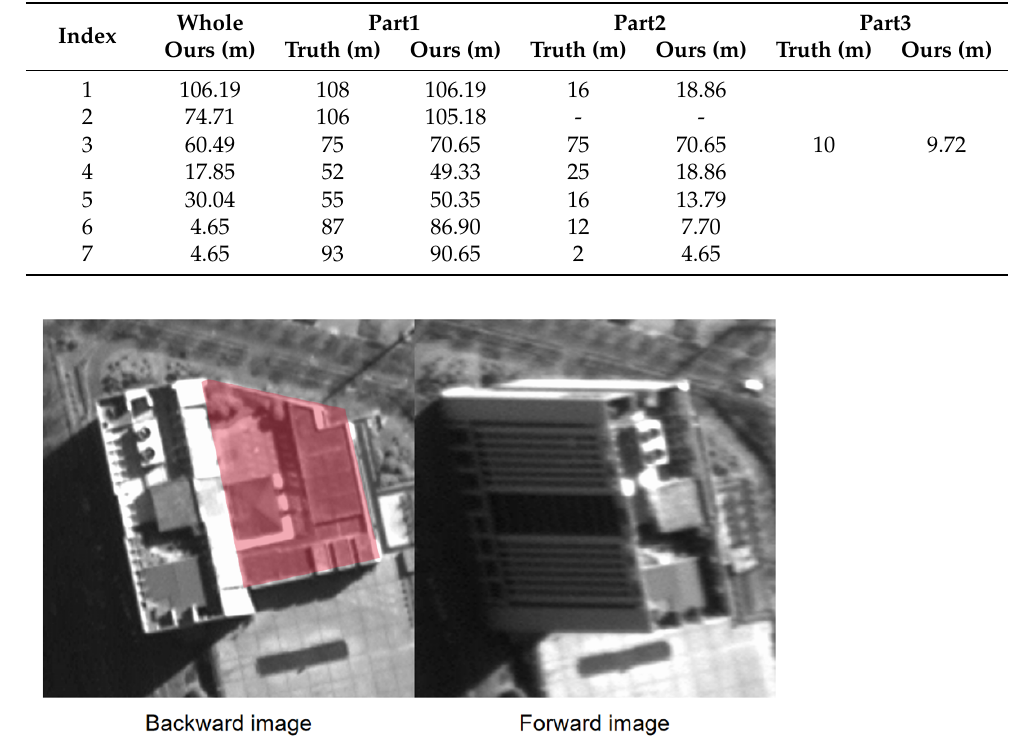
Table 8. Accuracy statistics of Podium building results in the study area.